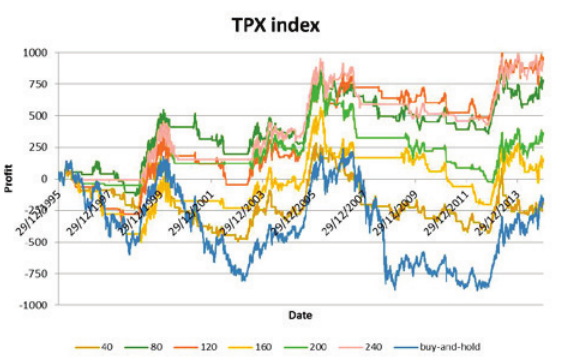
Figure 8. Profits of our strategy and “buy-and-hold” on TPX index (without transaction costs)